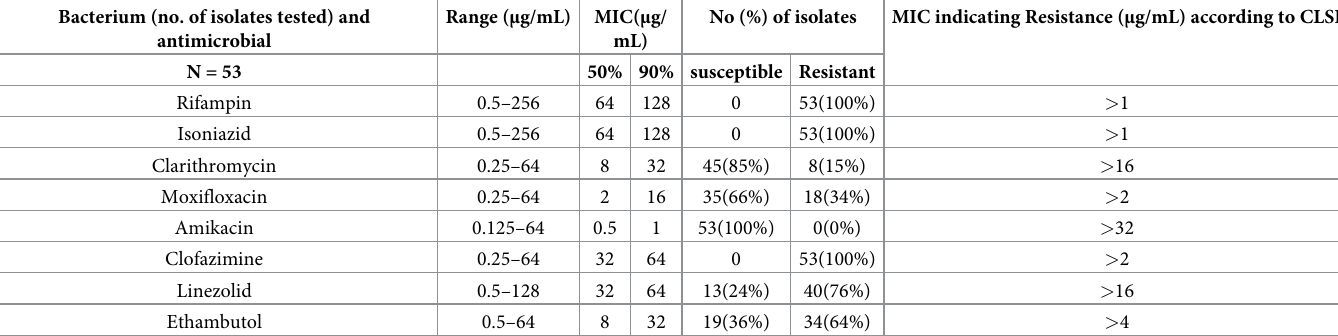
Table 3. Susceptibility of the M . simiae isolates to 8 antimicrobial agents determined by the microbroth dilution method. Bacterium (no. of isolates tested) and